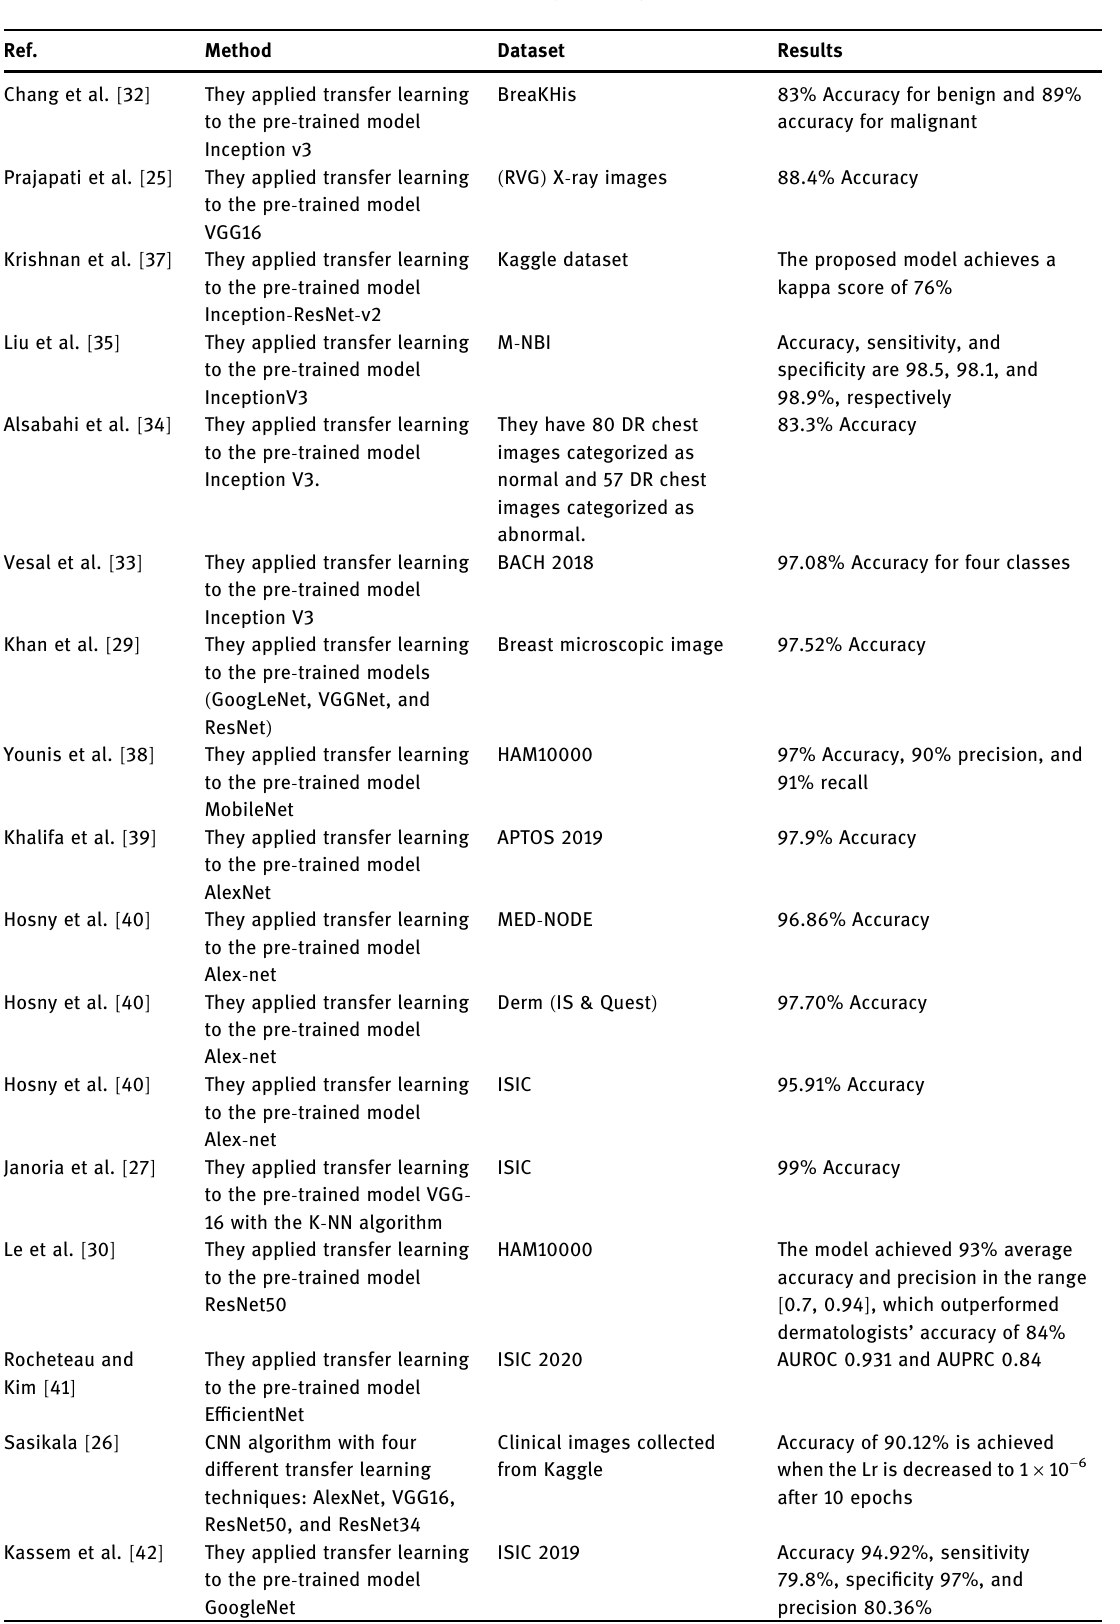
Table 1: Authors ’ fi ndings when using transfer learning techniques with pre - trained CNN models